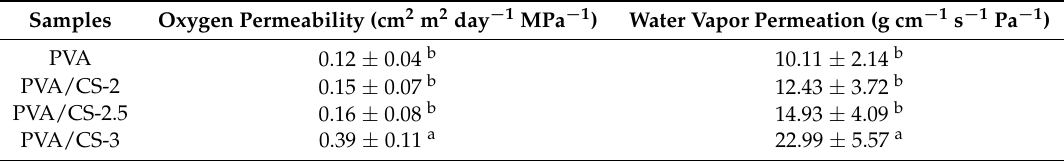
Table 2. Oxygen permeability and water vapor permeation of different films.